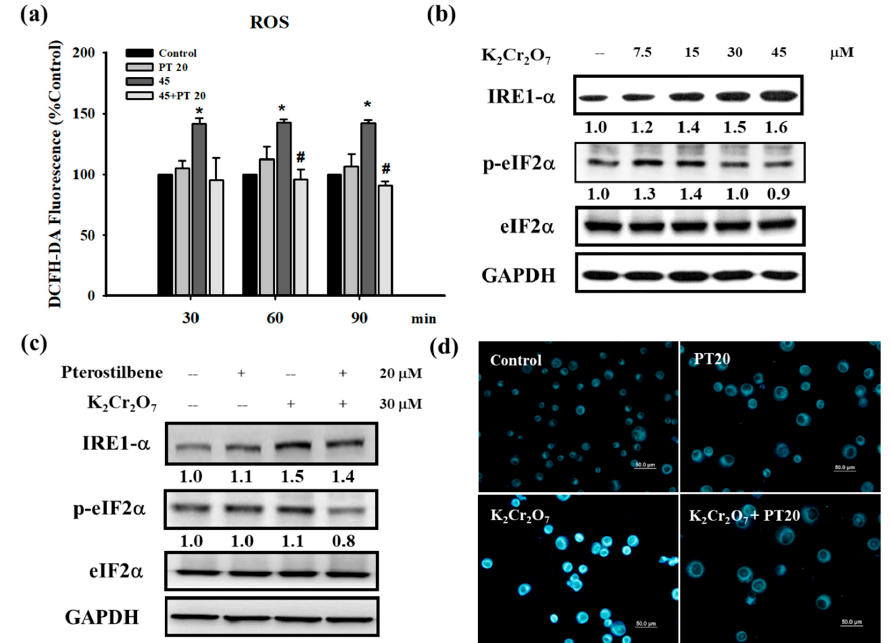
Figure 6. Cr(VI) treatment induced ROS and ER stress in HaCaT cells, which were inhibited by